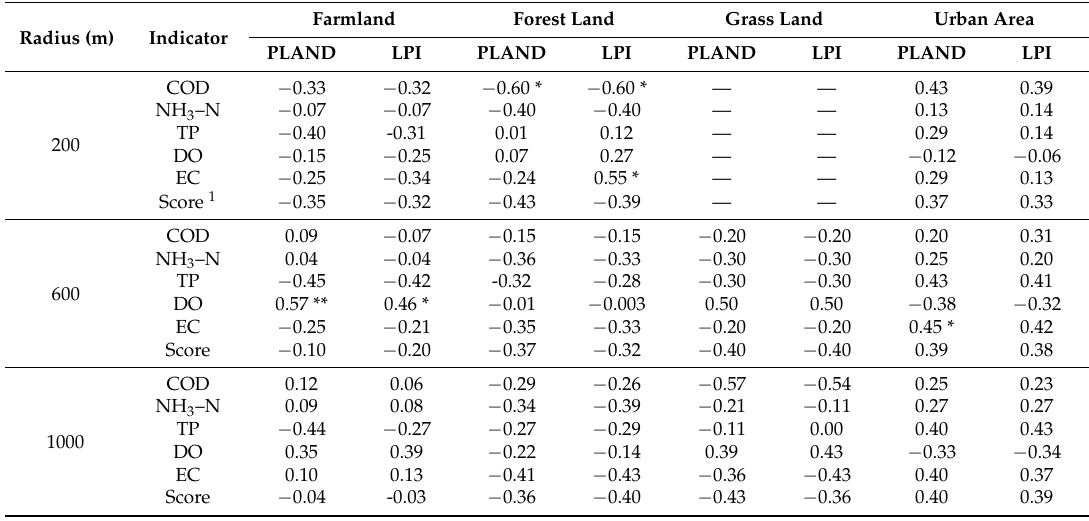
Table 3. Correlations between PLAND , LPI, and surface water quality